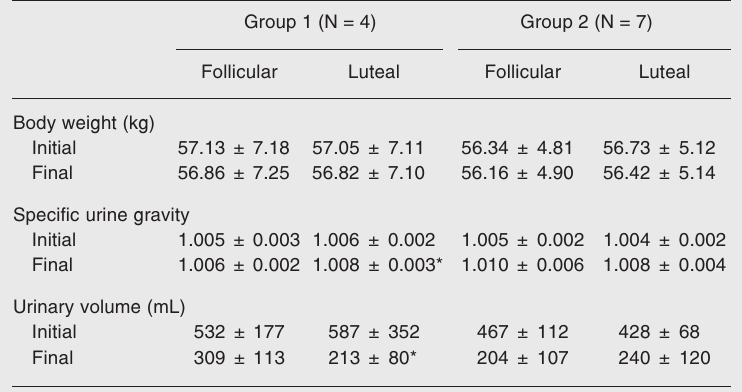
Data are reported as means ± SD. Group 1 = serum progesterone concentration compatible with ovulation (>3 ng/mL). Group 2 = serum progesterone concentration not compatible with ovulation. *P < 0.05 compared to the follicular phase of the menstrual cycle within the same group (Student t